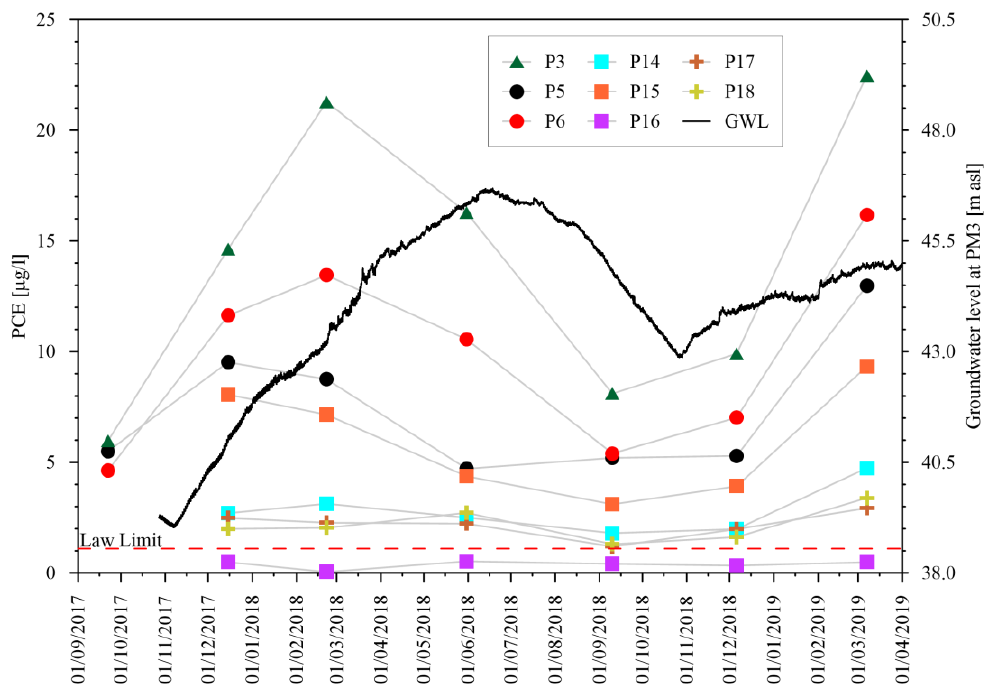
Figure 8. PCE concentrations. Observed at monitoring wells during the sampling campaigns. The groundwater level was observed at P24.